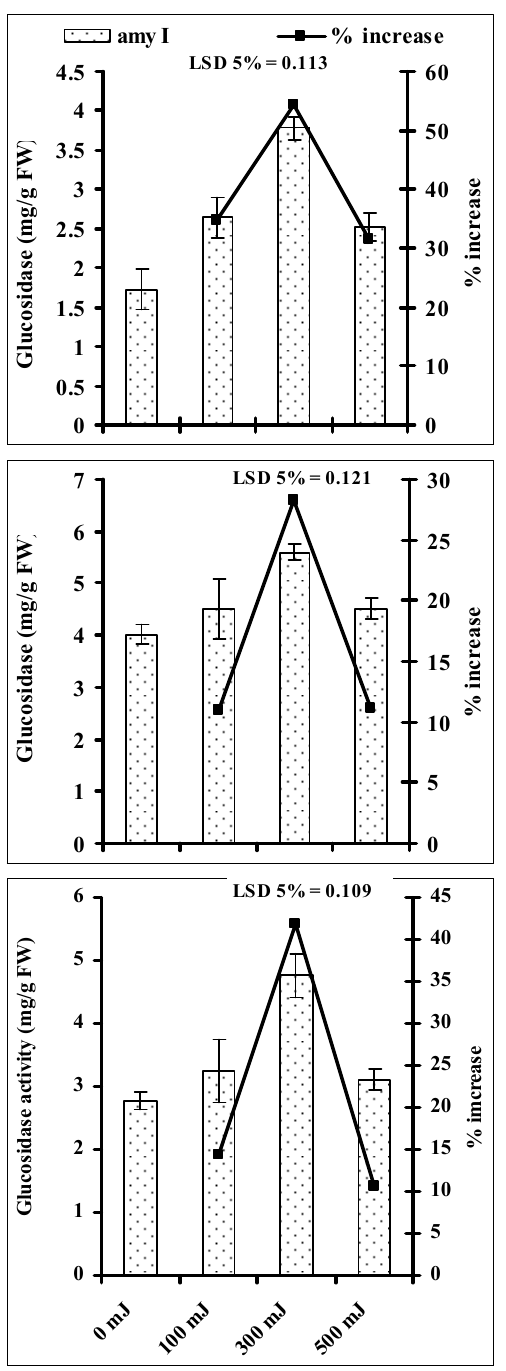
Figure 4. Activity of glucosidase during germination of safflower ( Carthamus tinctorious L.) seeds irradiated with He–Ne laser of different energies (mean ± SE; n = 4).